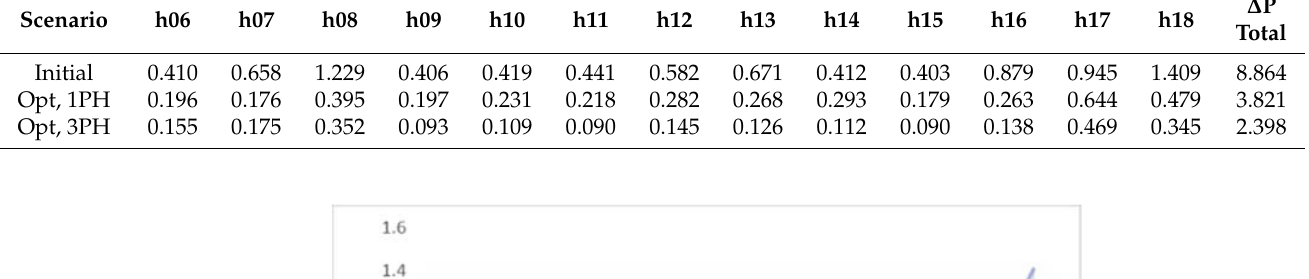
Table 5. Power losses in network R28, hourly and total, in the interval 06:00–18:00, kW.